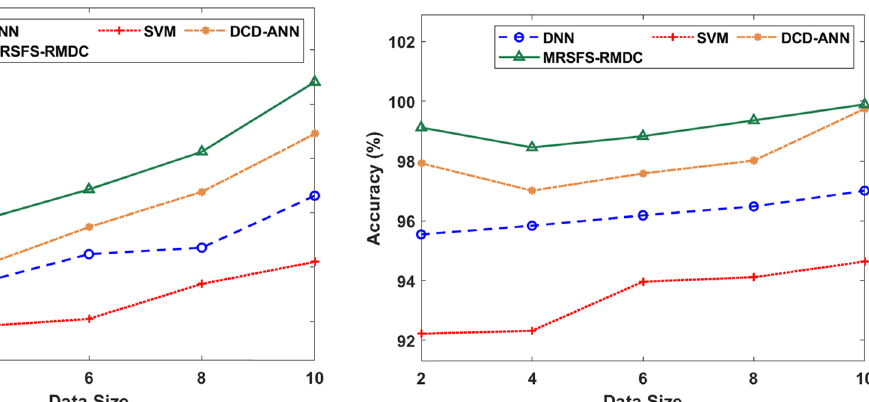
Figure 6: Accuracy analysis of MRSFS - RMDC model with distinct